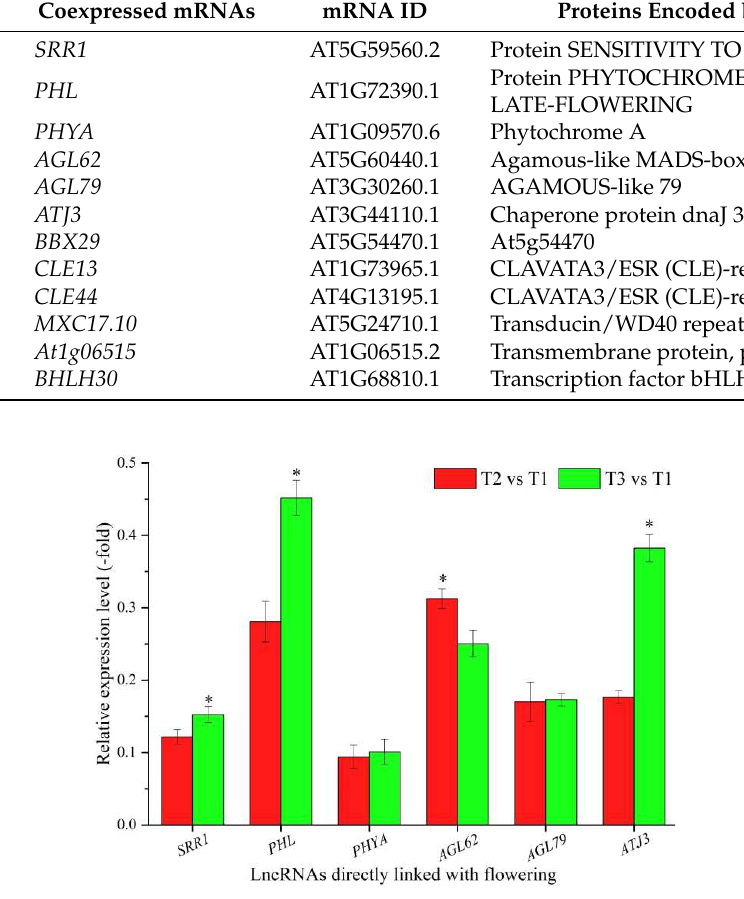
Table 3. Twelve lncRNAs directly linked with flowering.